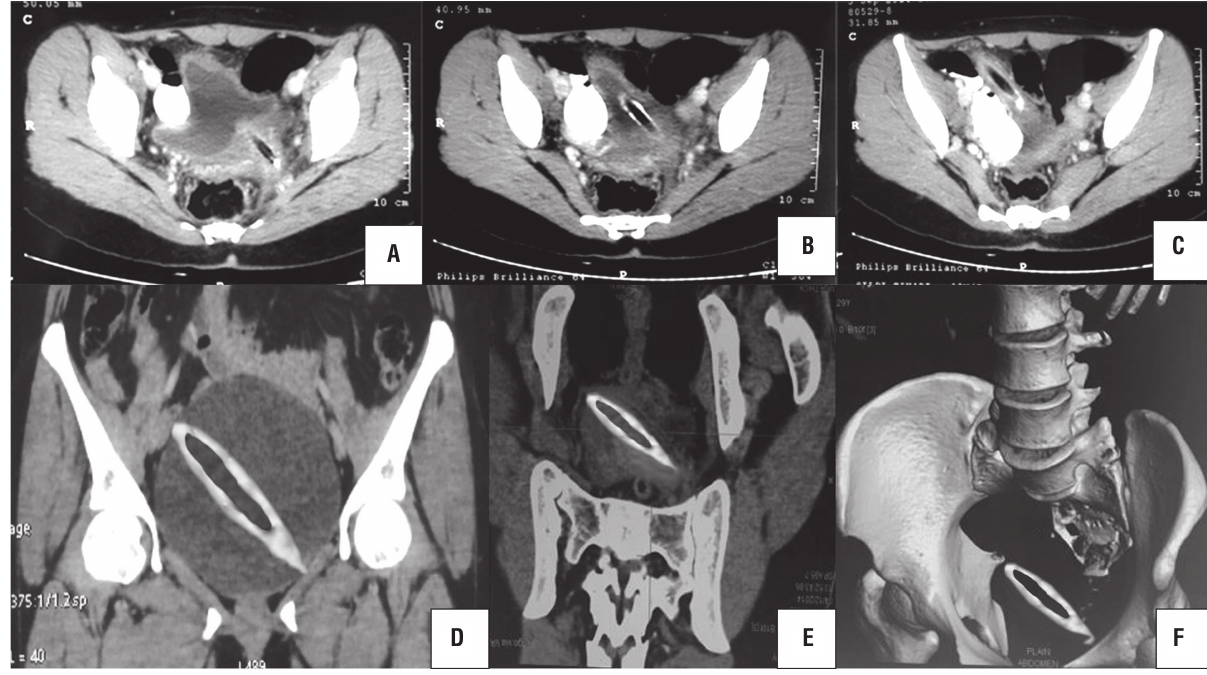
figure 1 - computed tomography scan [axial section (A-c) and coronal section (D-f)] showing hypodense linear foreign body (10.2 x 1.2cm) piercing the anterior vaginal wall and left posterior bladder wall with majority of its part lying inside the bladder. The tip of foreign body pierced right to anterior bladder wall and reached the abdominal wall.